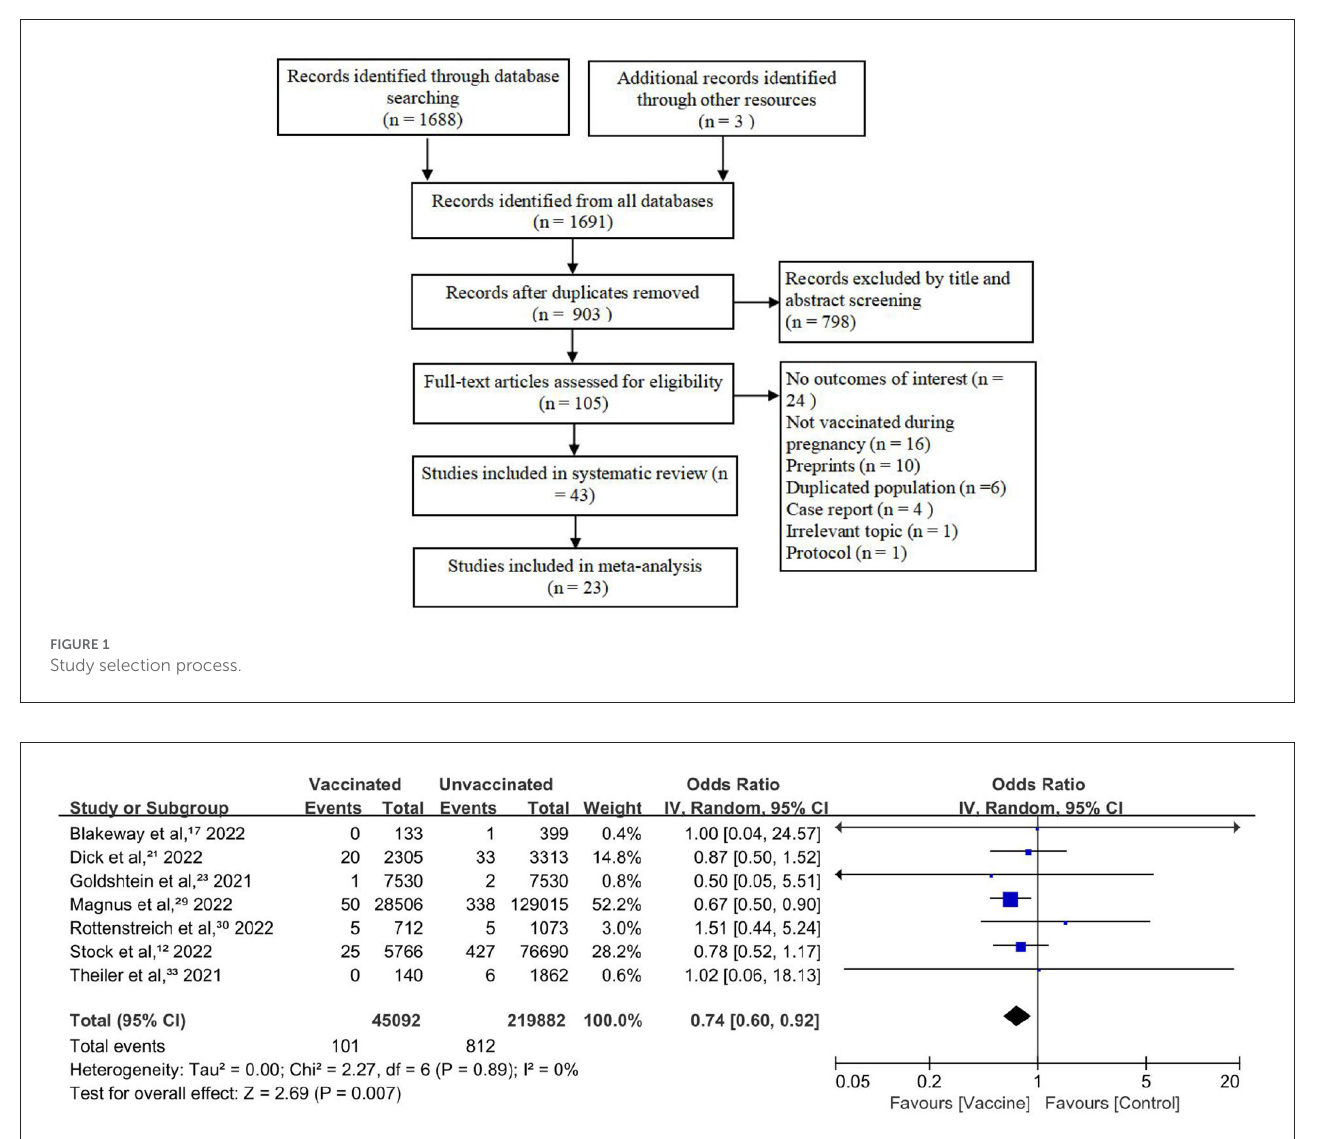
FIGURE2 Forest plot for stillbirth or neonatal